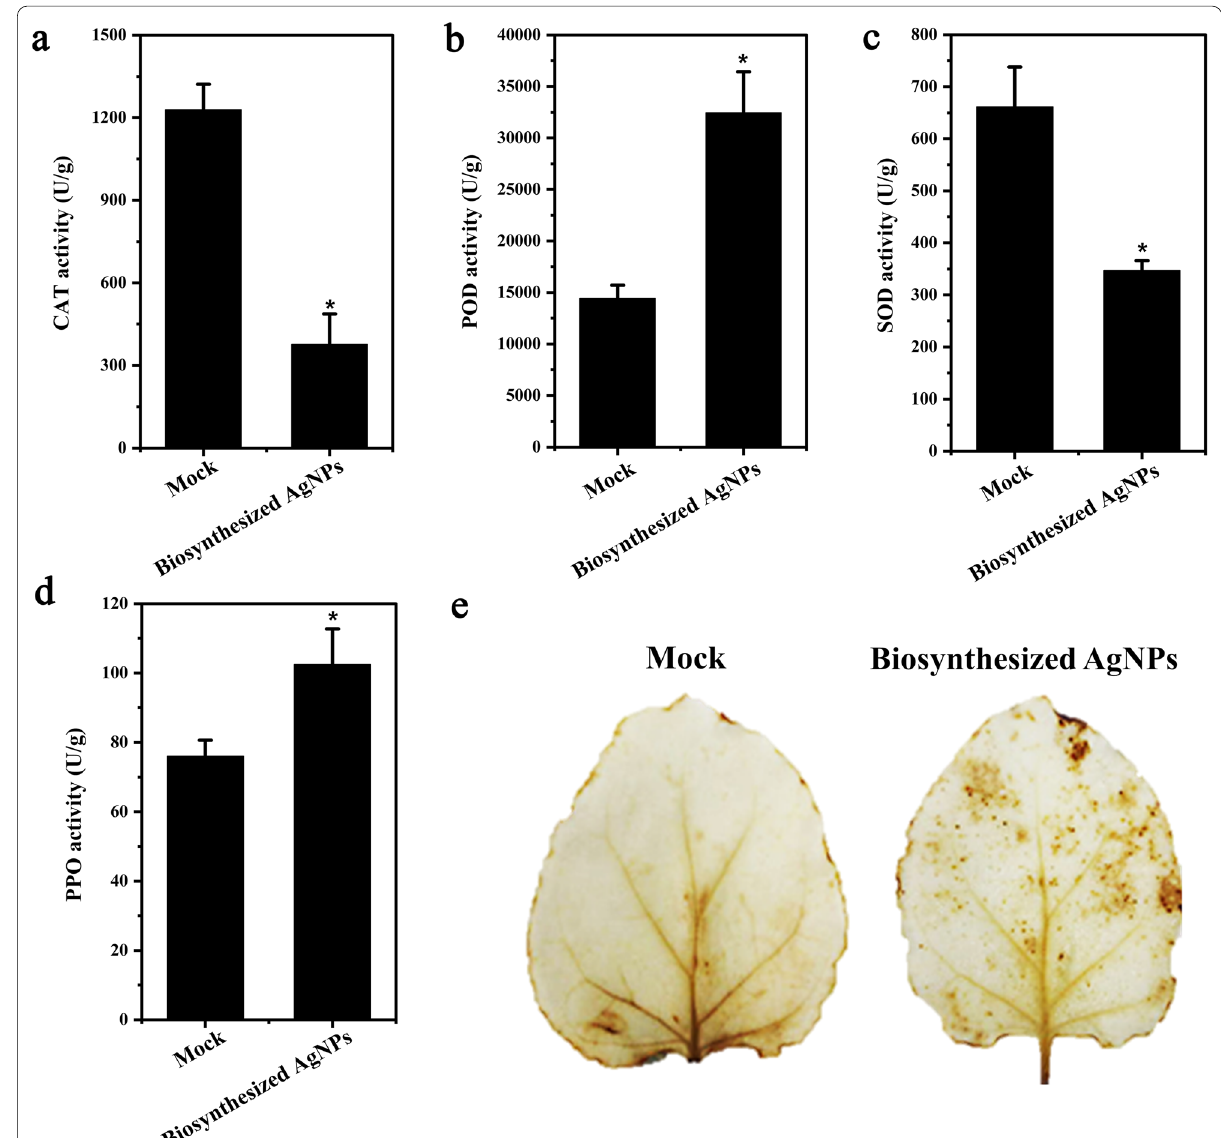
Fig. 4 Biosynthesized AgNPs induce antioxidant activity in Nicotiana benthamiana . a – d Activities of catalase ( a ), polyphenol oxidase ( b ), superoxide dismutase ( c ), and peroxidase ( d ) were measured after biosynthesized AgNPs treatment (1.2 μg/mL) for 3 times (once per day). e DAB staining was used to detect the production of H 2 O 2 in N. benthamiana after biosynthesized AgNPs treatment (1.2 μg/mL) for 3 times (once per day) . Mock, negative control (treated with sterilized distilled water). The data are